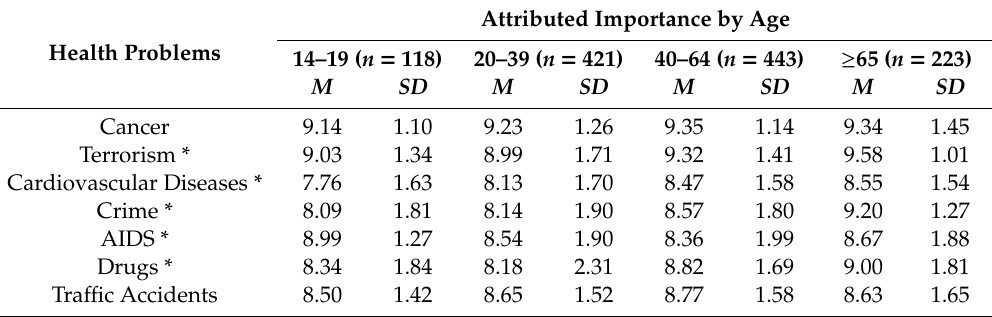
Table 4. Valuation of importance of social and health problems according to age.